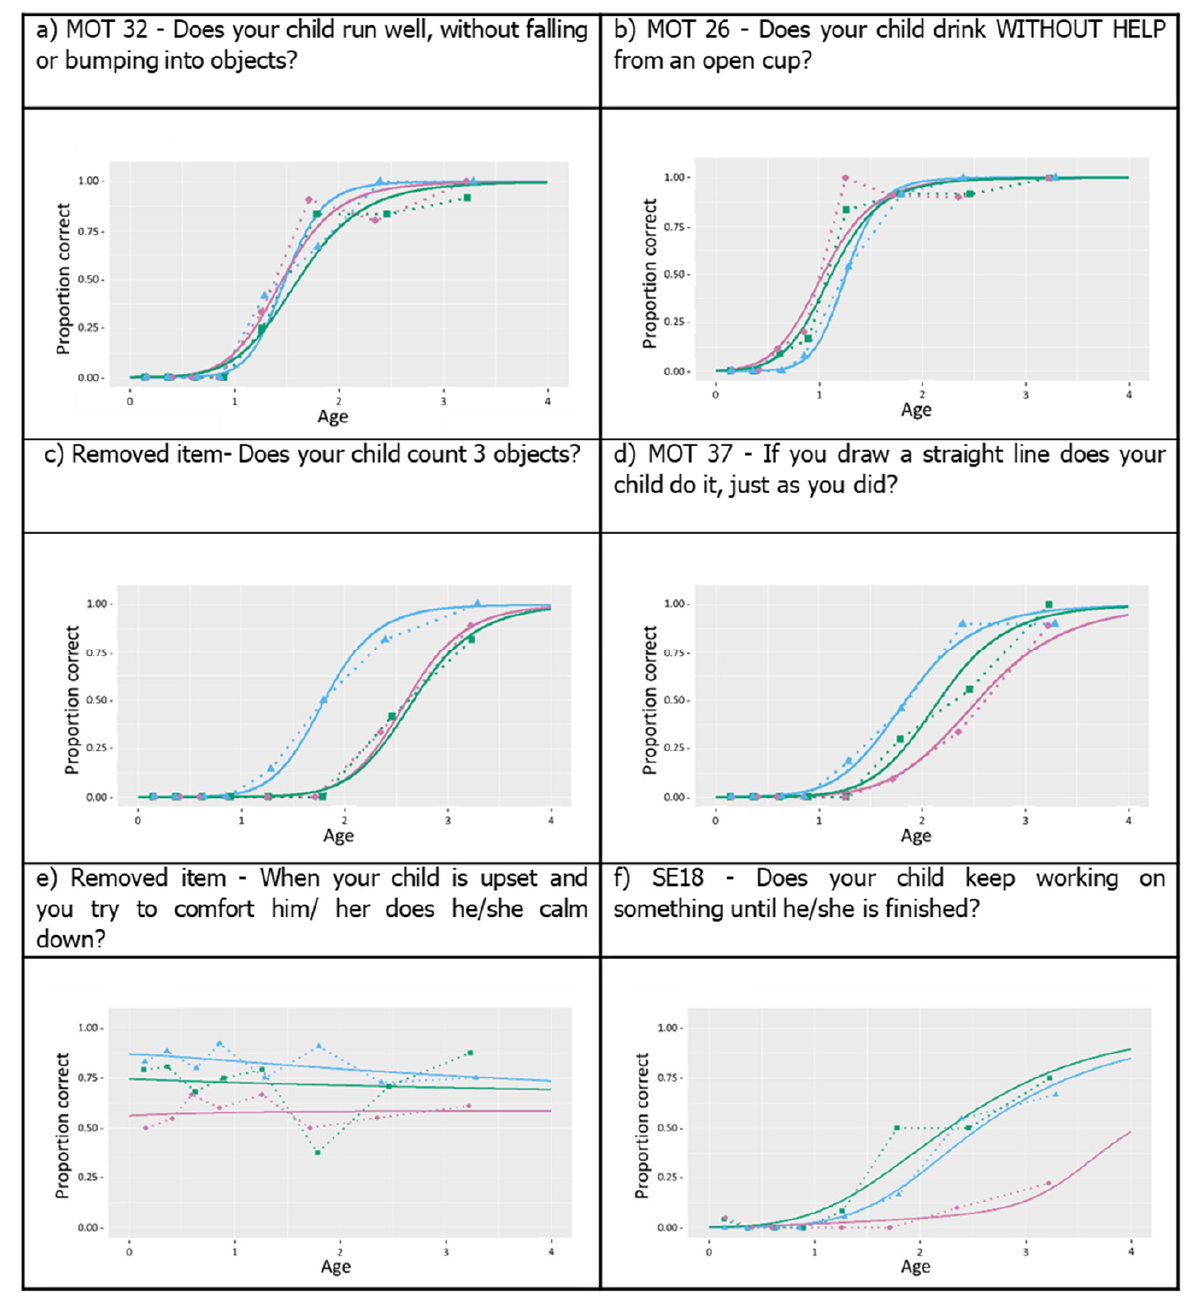
Figure 3. Examples of logistic regression of items. The first two plots, ( a ) and ( b ), show clear developmental trajectories by age for each country, with agreement between countries. The next two plots, shown in ( c ) and ( d ), display items that have good developmental trajectories but also some differences between countries. Examples of two poorly performing items are shown in ( e ) and ( f ). Green—Pakistan, Blue—Malawi, Pink—Brazil.